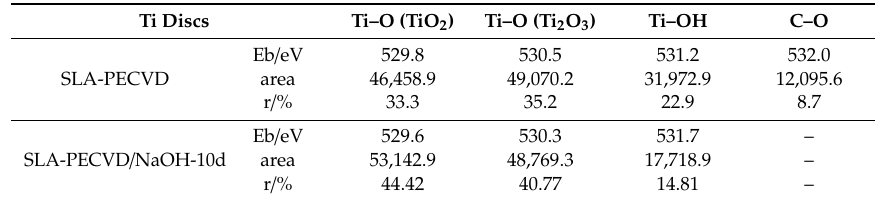
Binding energy, area, and proportion of the O1 s peaks for the SLA-PECVD and SLA-PECVD / NaOH-10d samples.